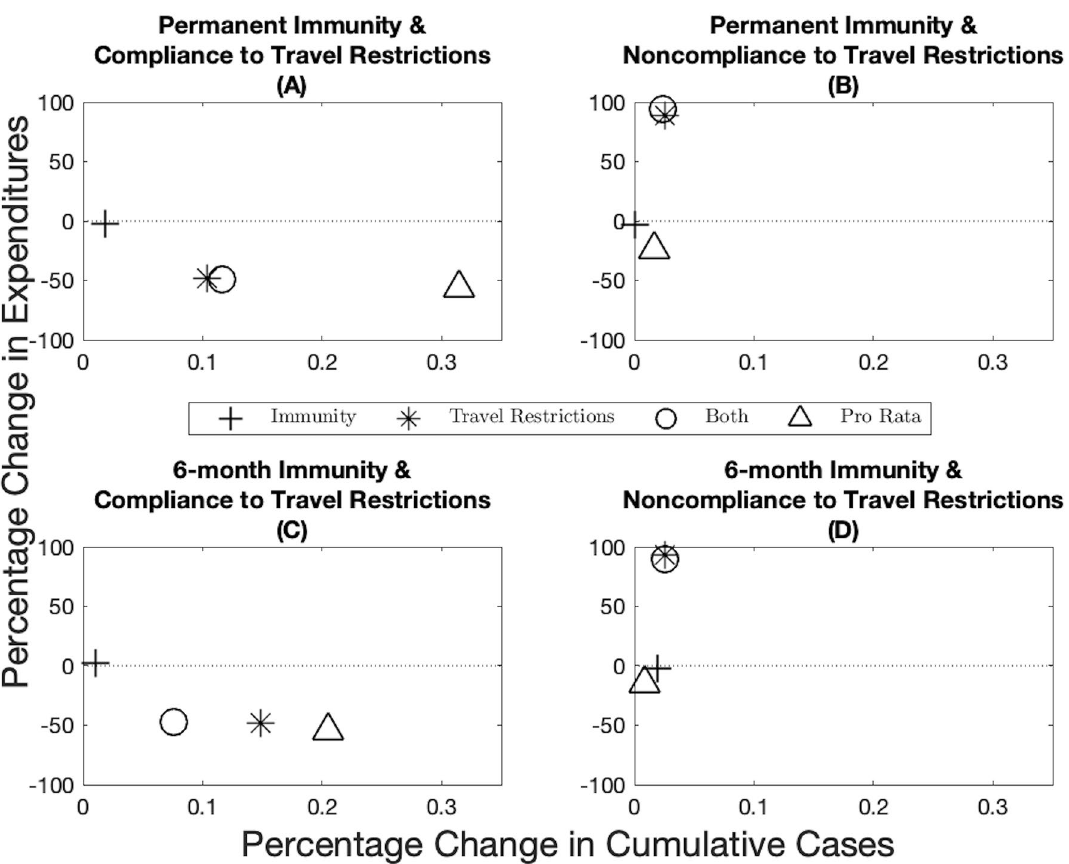
Figure 3. Robustness of epidemiological and economic outcomes under different scenarios when the source of heterogeneity is the timing of the outbreak (the outbreak started earlier in one jurisdiction). Percentage change in expenditures ( y -axis) and percentage change in cumulative cases ( x -axis) from the optimal allocation for different immunity-travel restrictions scenarios and for when vaccine capacity is 10%. The x -axis represent small percentage changes but when scaled up to population level effects translate into significant differences in public health